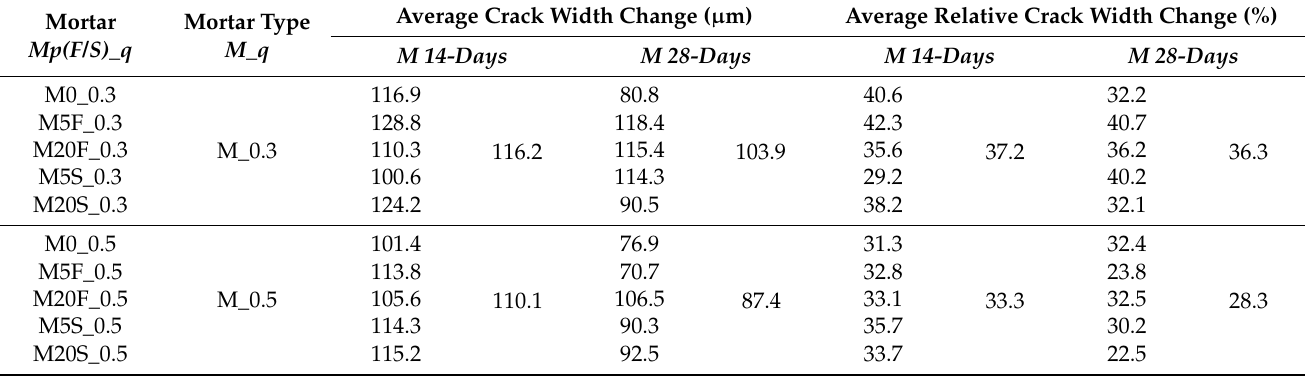
Table 5. Absolute and relative changes in crack width after 122 days of curing after crack induction; average values are given for mortars and mortar types.